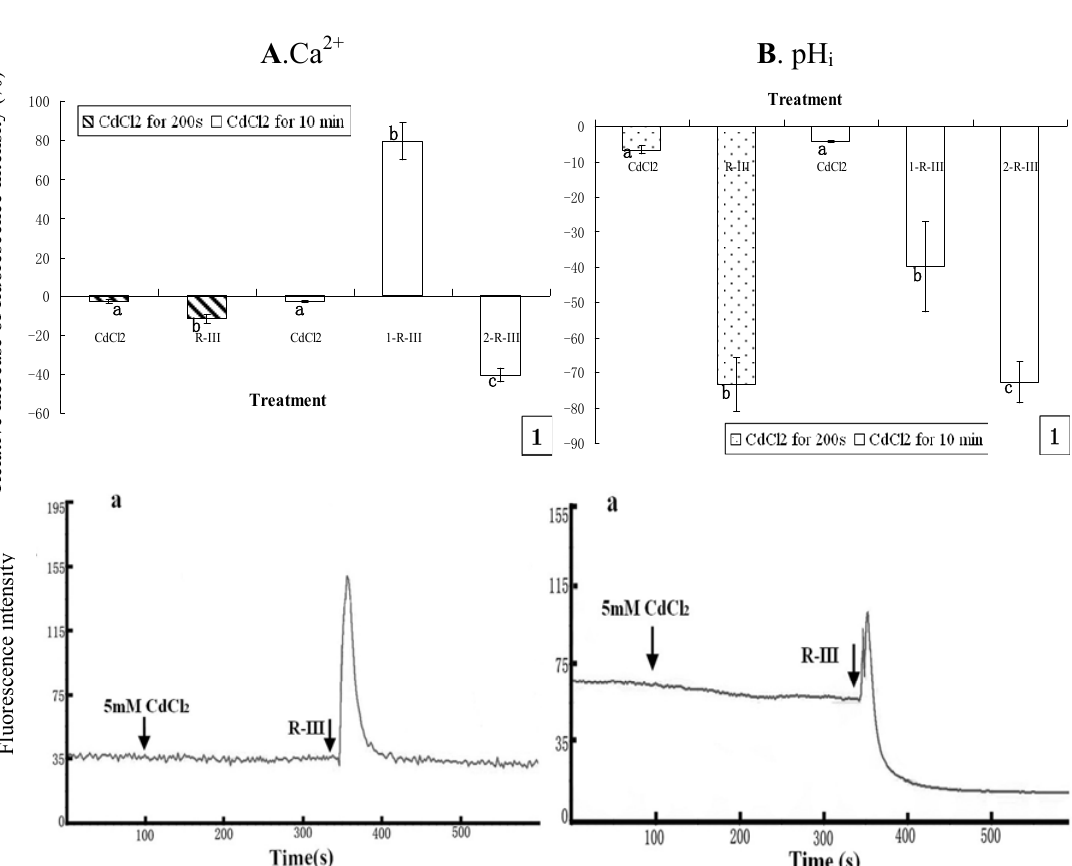
Figure 7. Effect of Ca 2+ channels block on [Ca 2+ ] and pH in R-III-induced Sf9 cells in i i presence of Dhanks. ( A1 ). changes of [Ca 2+ ] in Sf9 cells treated with 0.5 mM CdCl for i 2 200 s and 10 min prior to stimulate with R-III (100 μ g/mL), as indicated by relative change of Fluo-3AM fluorescence intensity; ( Aa ). Dynamic changes of [Ca 2+ ] in Sf9 cells i incubated with CdCl (5 mM) for 200 s prior to stimulate with R-III (100 μ g/mL); 2 ( A-b ). Dynamic changes of [Ca 2+ ] in Sf9 cells incubated with CdCl (5 mM) for 10 min i 2 prior to stimulate with R-III (100 μ g/mL) for two times; ( B ). pH profile in cells i